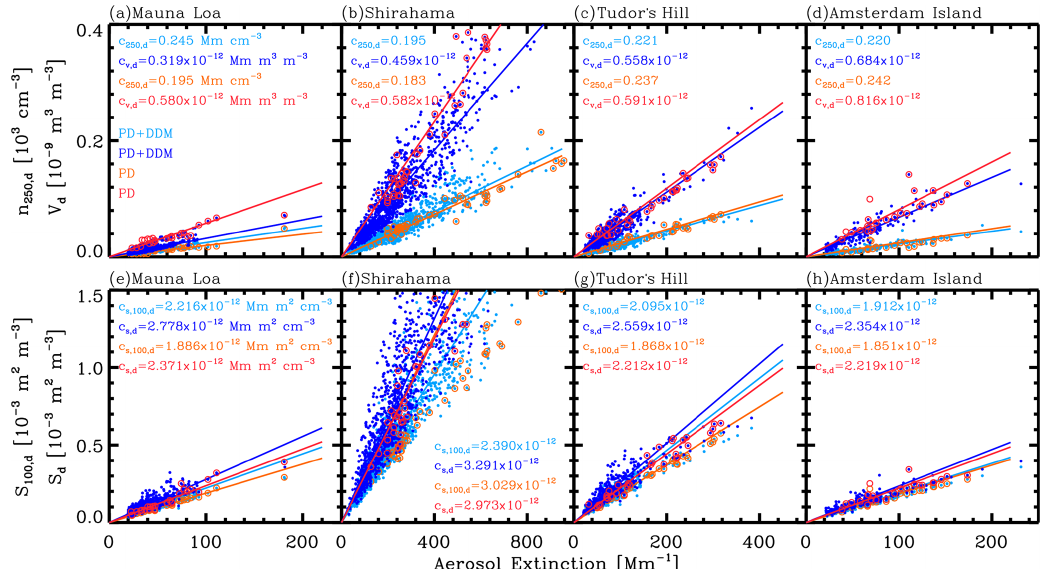
Figure 5. Relationship between the aerosol extinction coefficient at 532nm and large particle (radius > 250nm) number concentration n 250 , d and volume concentration v d , as well as surface area concentration s d and s 100 , d (radius > 100nm) for DDM+PD (in light blue and blue) and PD (in orange and red) at four typical ocean and coast sites, i.e., (a, d) for Mauna Loa, (b, f) Shirahama, (c, g) Tudor Hill, and (d, h) Amsterdam Island. The PD and DDM data points are selected from the AERONET Version 3 database (level-2.0 AOD products and level-1.5 aerosol inversion products) using the dust ratio threshold derived with the method given by Shin et al. (2019). The corresponding values of dust-related conversion factors c v , d , c 250 , d , c s , d , and c s , 100 , d are also given, respectively.